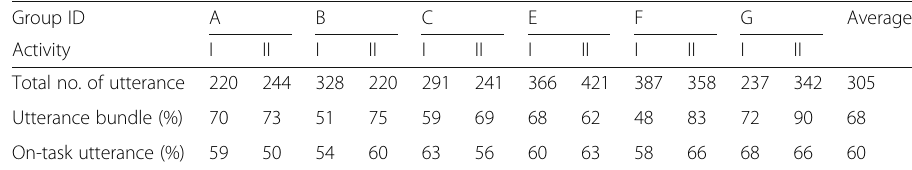
On-task utterance (%)